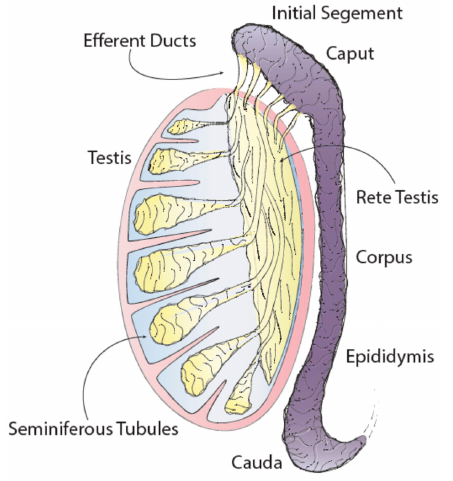
Figure 1. Testis and epididymis anatomy.